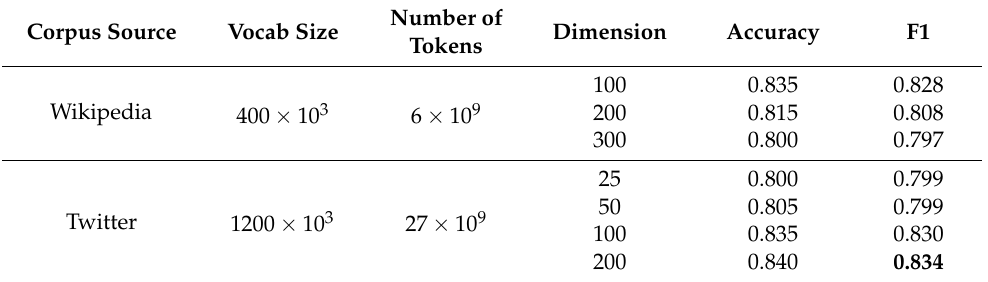
Table 13. Glove hyper-parameter search.